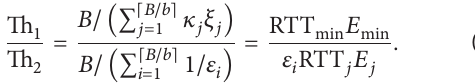
Figure 5: The routing of opportunistic mechanism.